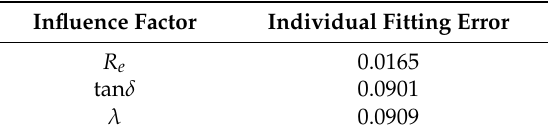
Table 2. Fitting errors for different influence